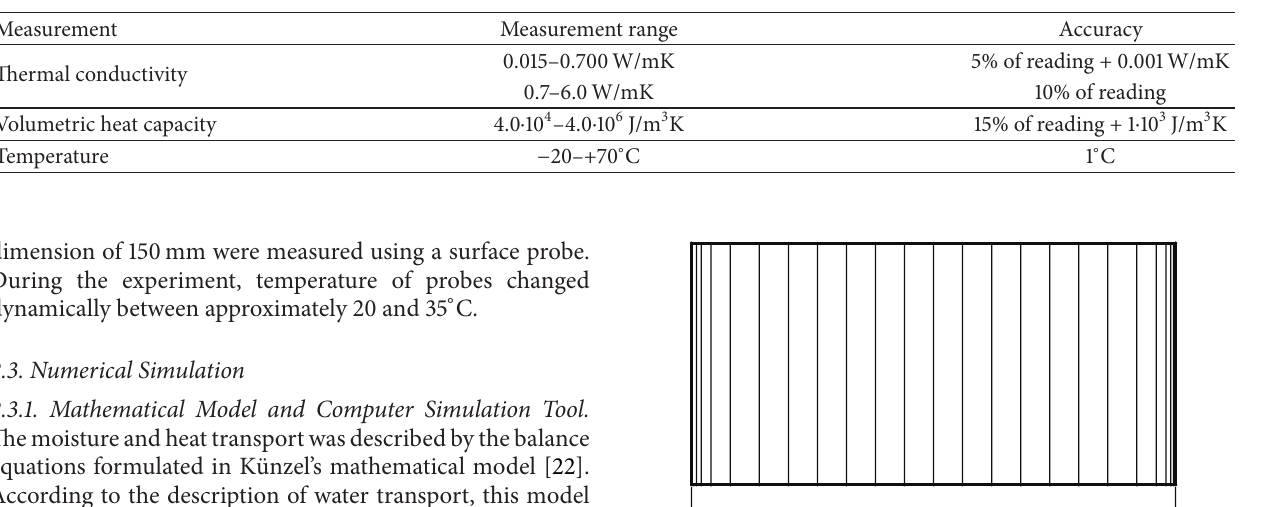
Table 3: Measurement accuracy of ISOMET 2114.